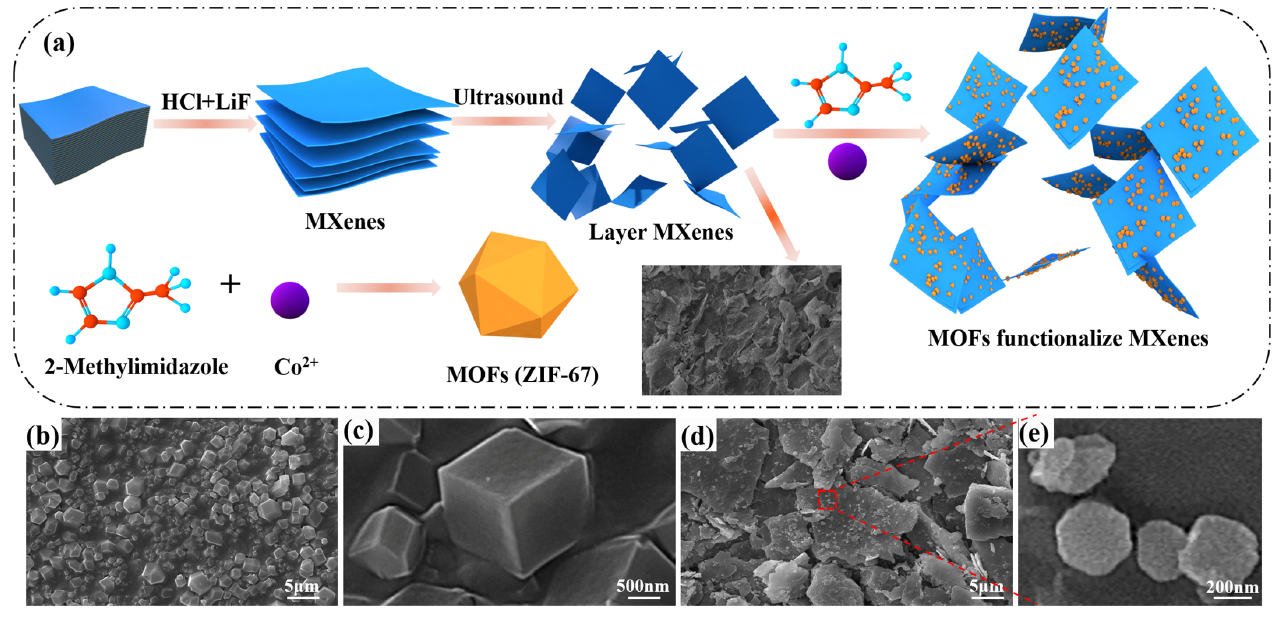
Figure 1. ( a ) Schematic for synthetic route of ZIF-67@MXene hybrids; SEM images of the residues for ( b , c ) ZIF-67 and ( d , e ) ZIF-67@MXene hybrids.